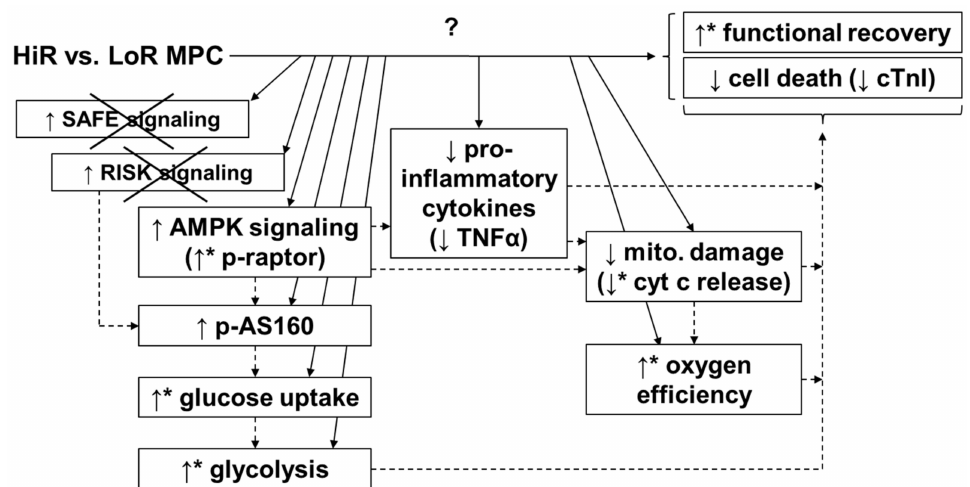
Figure 7. Potential mechanism for MPC-induced cardioprotection. HiR MPC hearts presented better functional post-ischemic recovery, as well as reduced release of cell death markers and lower tissue levels of pro-inflammatory cytokines, compared with LoR MPC hearts. Increased AMPK activation (raptor and AS160), greater glucose uptake and glycolysis, and less mitochondrial damage may all contribute to the cardioprotective e ff ects of MPC. No evidence for the involvement of the SAFE or RISK pathway was observed (as indicated by the “x” in the figure) under these conditions. ↑ : higher in HiR vs. LoR MPC hearts. ↓ : lower in HiR vs. LoR MPC hearts. ↑ or ↓ with *: p < 0.05 between HiR and LoR MPC hearts, ↑ or ↓ without * indicate non-significant tendency between HiR and LoR MPC hearts. Arrows (continuous lines) connecting boxes: demonstrated relationship. Arrows (dashed lines) connecting boxes: expected / proposed relationship. AMPK, AMP-activated protein kinase; AS160, Akt substrate of 160 kDa; cTnI, cardiac troponin I; cyt c, cytochrome c; HiR, high recovery; LoR, low recovery; MPC, mechanical postconditioning; raptor; regulatory associated protein of mTOR; RISK, reperfusion injury salvage kinase; SAFE, survivor activating factor enhancement; TNF α , tumor necrosis factor